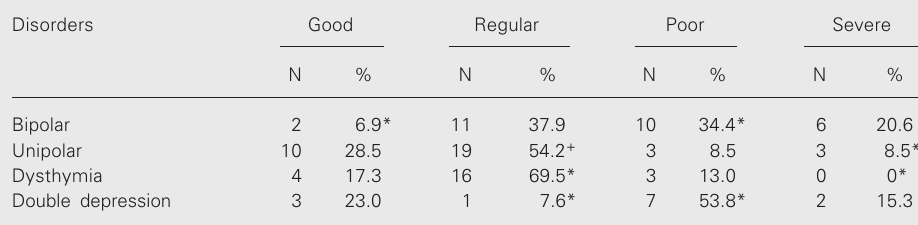
Table 3. Scores for mood disorder patient on the Disability Adjustment Scale.